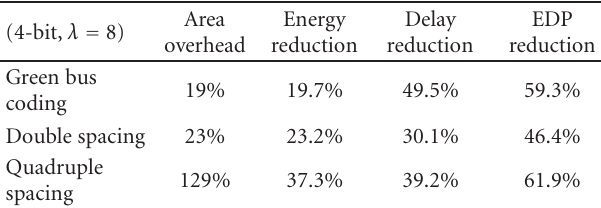
Table 1: Comparisons between green bus coding and increasing wire